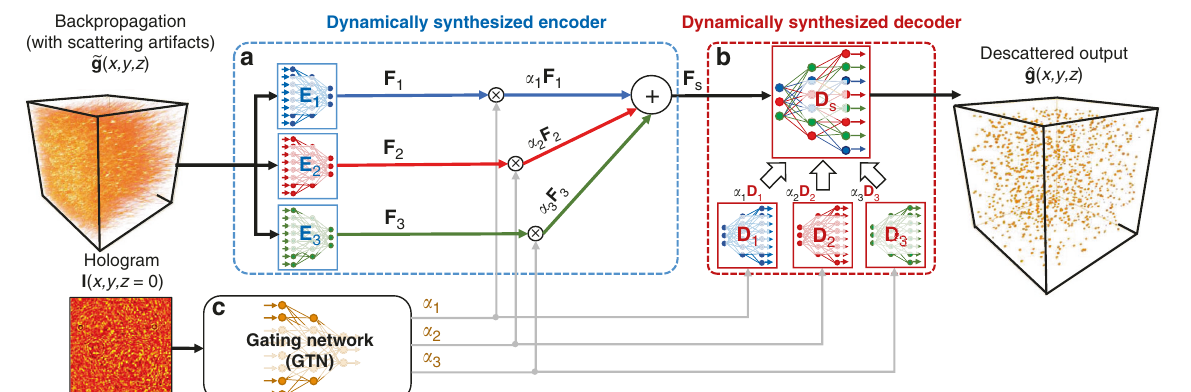
Fig. 1 Dynamic synthesis network (DSN) framework. The DSN combines multiple DNNs for adaptively removing scattering artifacts in the input. a In the fi rst stage, the expert encoders E i ( i ∈ ; {1, 2, 3}) extract a diverse set of multi-scale spatial features from the holographically backpropagated input volume ~ g. The extracted multi-scale feature maps from each encoder are labeled as F i . To adaptively process an input with an arbitrary scattering condition, a dynamically synthesized feature map F s is computed as a weighted sum of the expert feature maps: F s ¼ synthesized feature F s is fed into a dynamically synthesized decoder D s to produce the descattered output ^ g. b Different from the encoder, the decoder D s is computed as a weighted sum of the expert decoders ’ network parameters: D s ¼ mechanism by predicting the synthesis weights α i based on the matching hologram